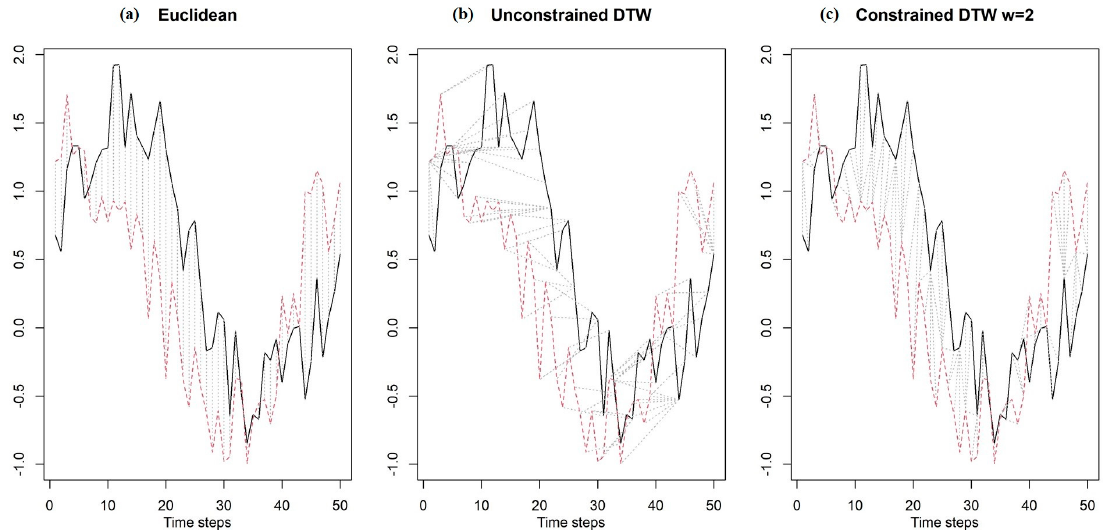
Figure 2. Graphic representation on synthetic data of ( a ) Euclidean distance, ( b ) unconstrained Dynamic Time Warping, ( c ) Dynamic Time Warping with reduced window size ( w = 2). Black and red lines are the synthetic time series generated through a sin function plus a random component, while the dotted grey lines indicate the association among the data of the two time series calculated with the three methods. Euclidean distance only allows for the comparison of the data at the same time step without any warping of the series, and even the slightest shift would increase the distance value. The DTW searches for similarities in the time series allowing for sweeping shift and warping of the time series, coupling also data which can be far in time. In this example, DTW couples data that are more than 10–15 time-steps away.